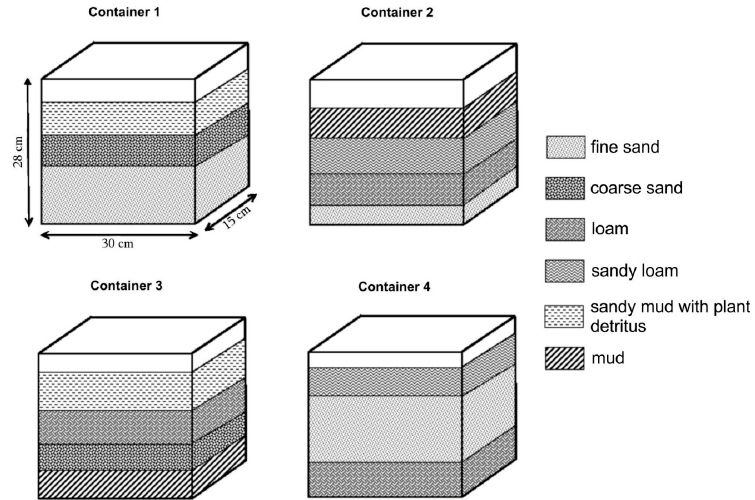
Figure 3. Parameters of containers used for mesocosm.